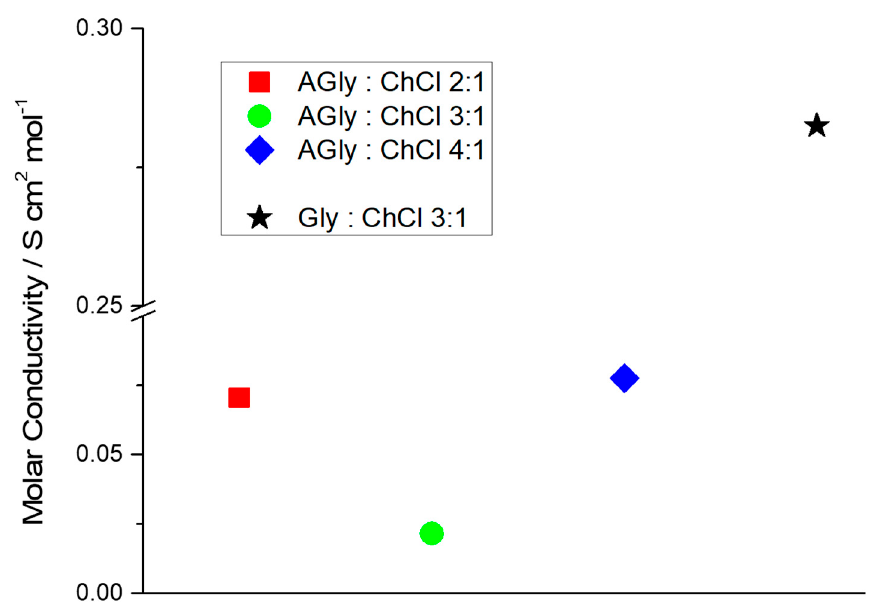
Figure 3. Molar conductivity of the mixtures AGly:ChCl 2:1 (red square), 3:1 (green circle) and 4:1 (blue diamond) at RT. The value of a DES based on Glycerol and ChCl (3:1) is reported as a comparison (black star). Table 2. Screening of the reaction conditions for the n -BuLi addition to model substrate 1a .